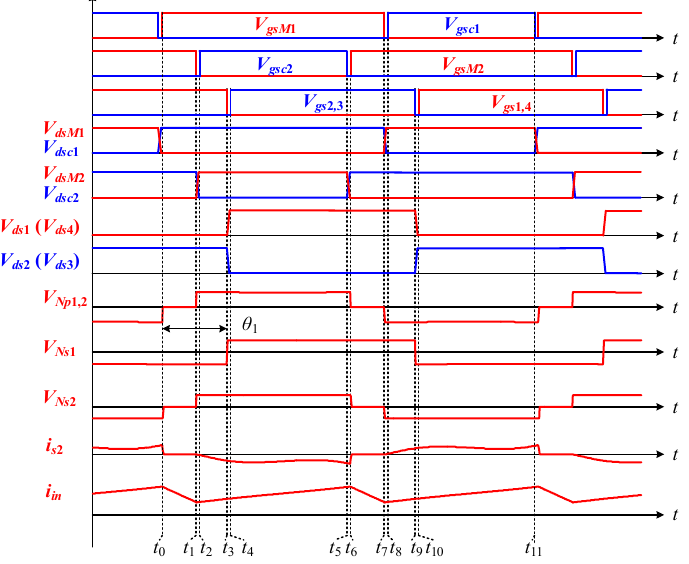
Figure 4. Operating waveforms of the basic cell with PV source.